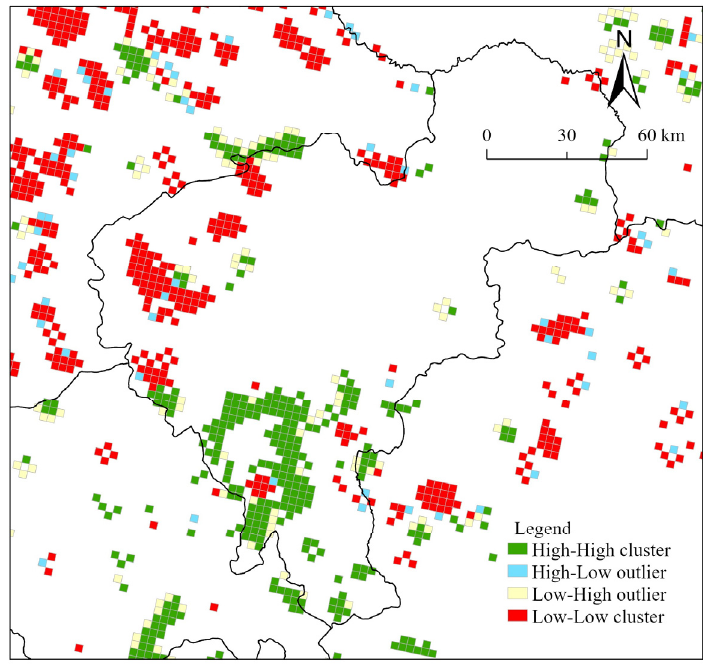
Figure 9. Example of high–high clusters around built-up areas.